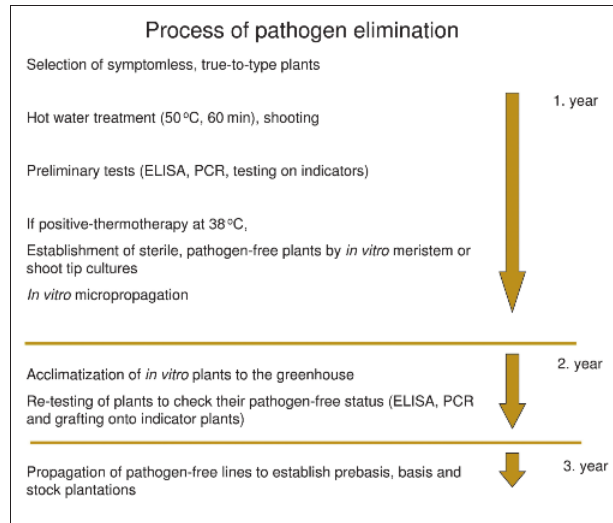
Figure 2. Procedure to produce pathogen-free